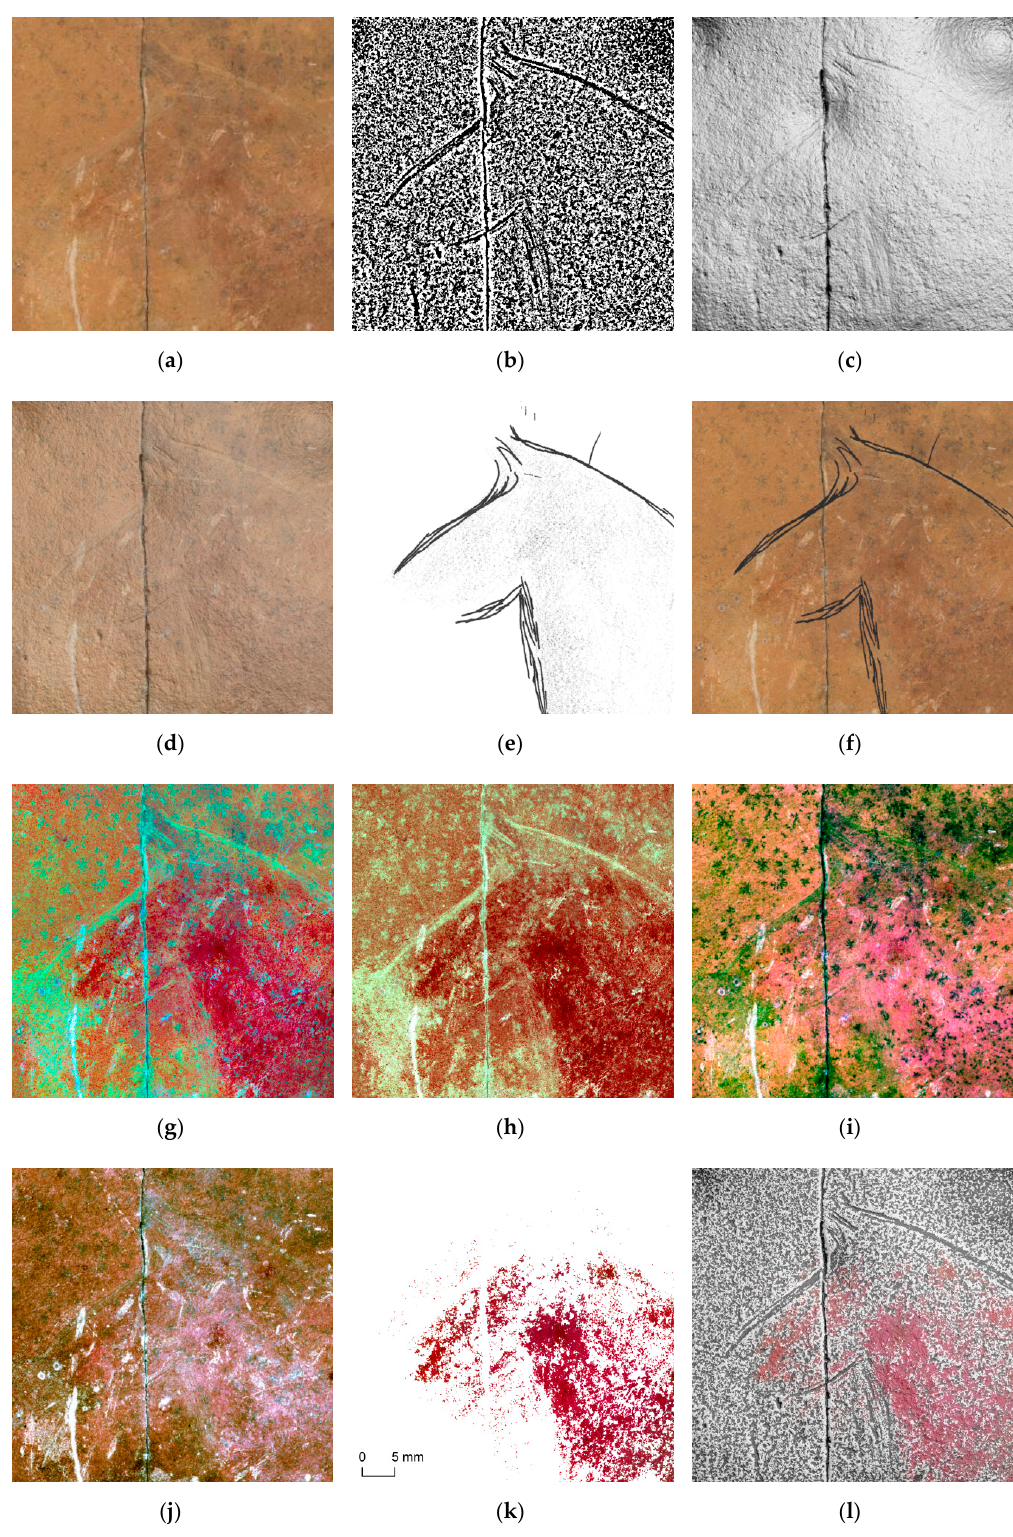
Figure 5. Detail image of the information layers incorporated into the project and the possible resulting combinations: ( a ) orthophotomosaic; ( b ) high pass filter; ( c ) hillshade; ( d ) overlay of layer ( c ) with a transparency of 35% on layer ( a ); ( e ) final tracing 1994; ( f ) overlay of layer ( e ) (masking lines only) on layer ( a ); ( g ) DStretch-LRE; ( h ) DStretch-YRE; ( i ) DStretch-YBG; ( j ) DStretch-LYE; ( k ) pigment masked from layer ( g ); ( l ) overlay of layer ( c ) with 50% transparency on layer ( k ), which in turn is superimposed on layer ( b